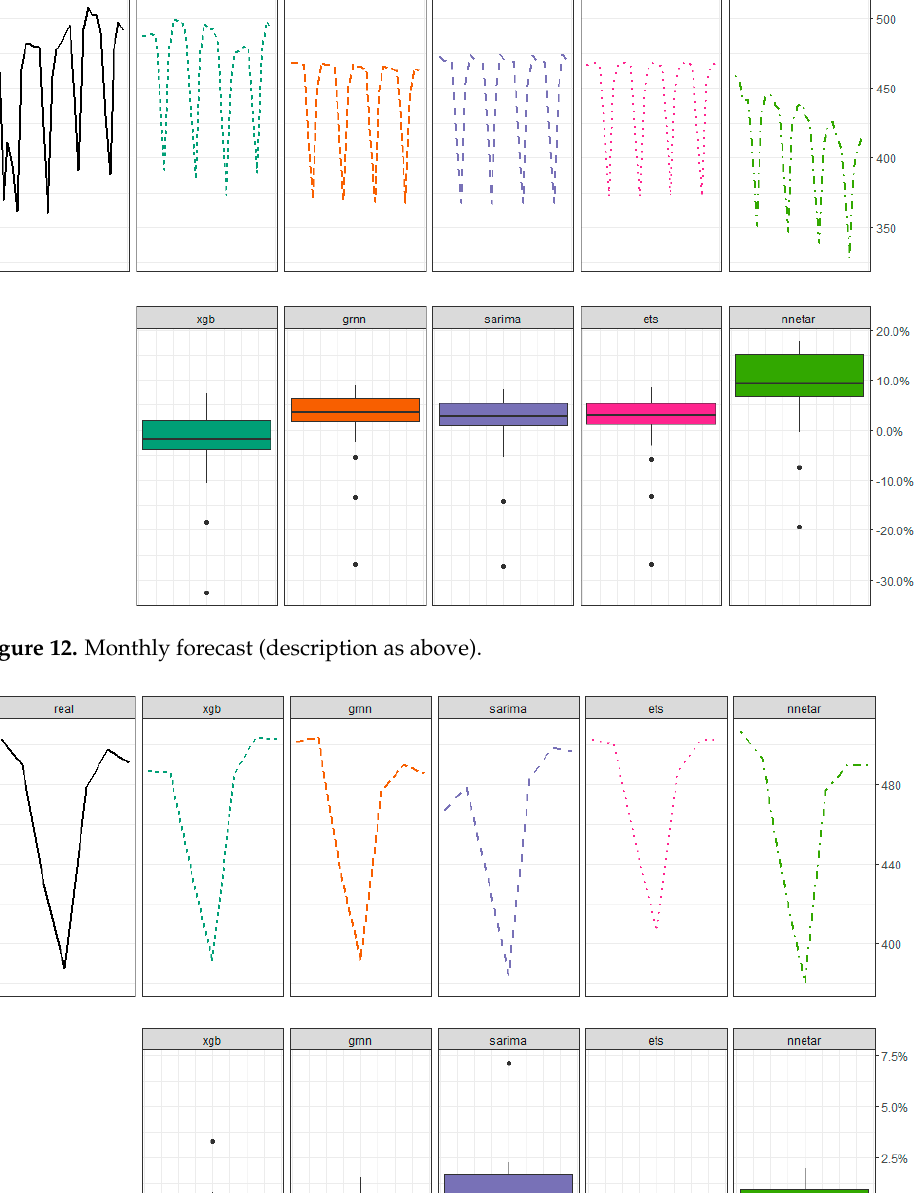
Figure 11. Quarterly forecast; Top panel: actual and forecast consumption course, bottom panel: boxplots of the relative error distribution of the forecasts in the tested scenario.